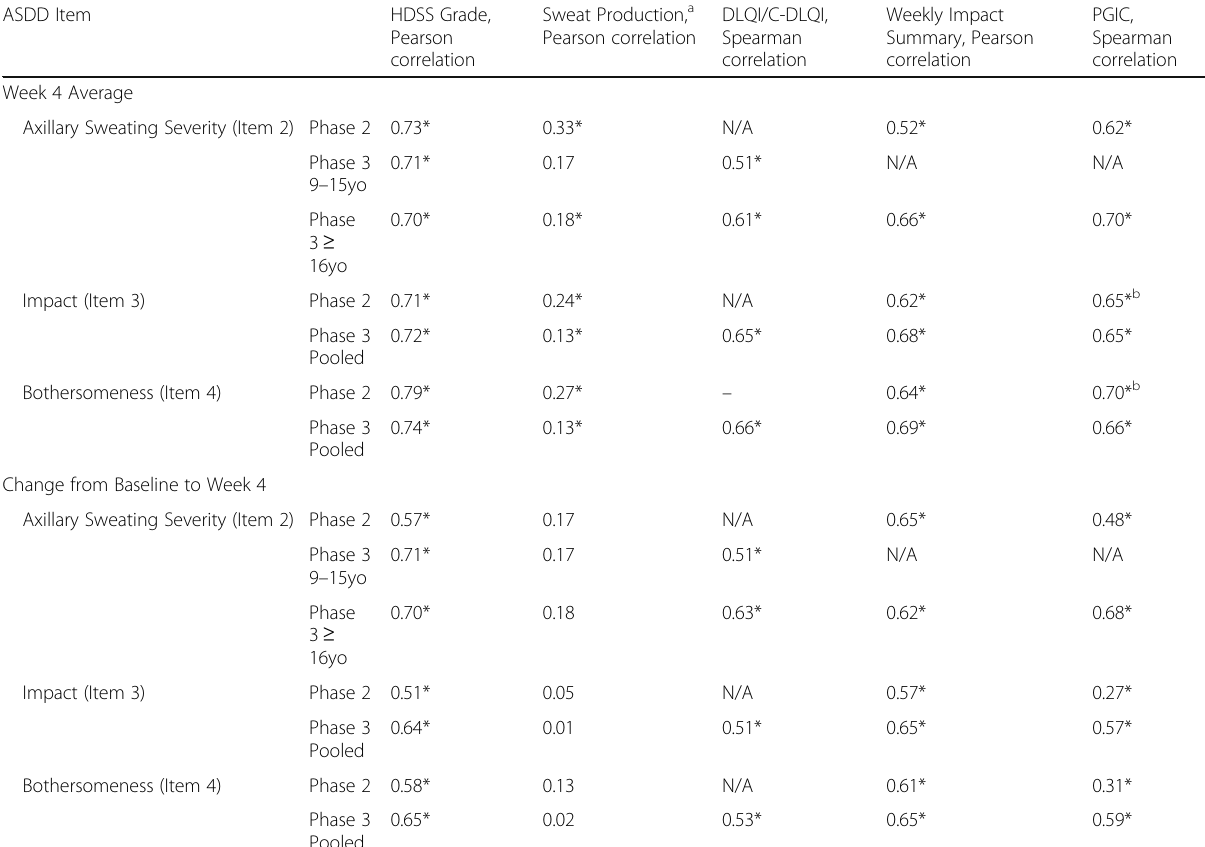
Table 5 ASDD Construct Validity Correlations at Week 4 (Phase 2 data; N = 105 or Phase 3 data; N =